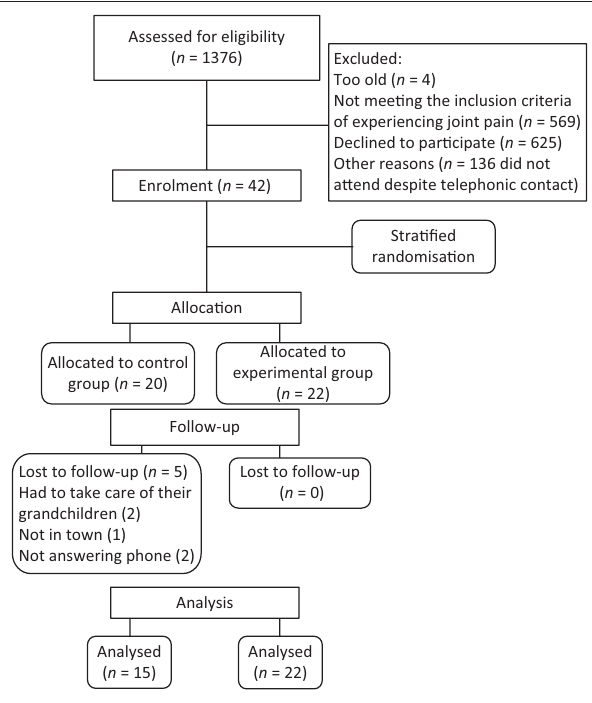
FIGURE 1: Flow chart of recruitment and